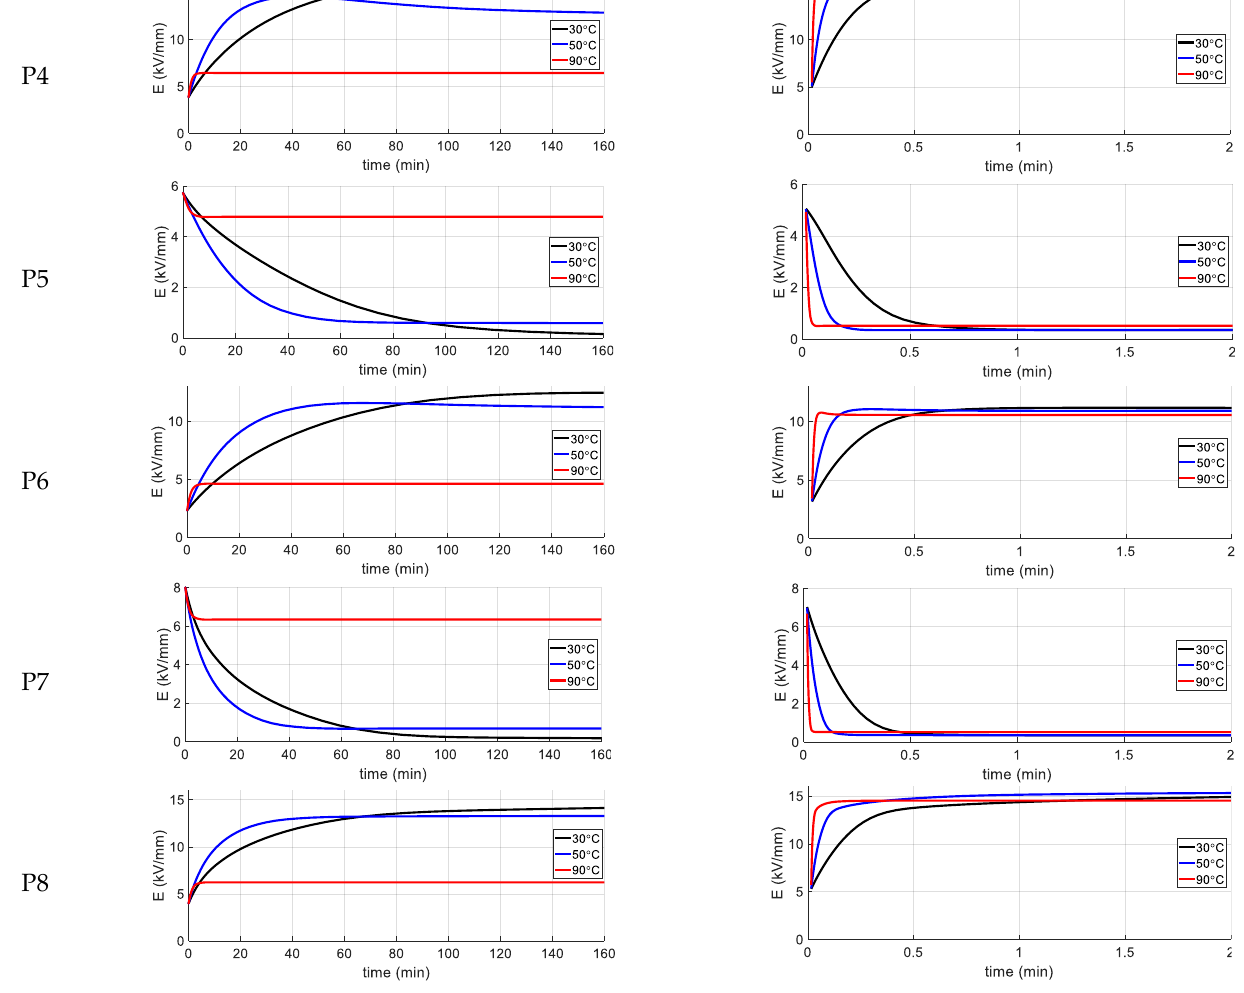
Figure 10. The time variation of stress curves of P1 to P8 using: ( left ) mineral oil; ( right ) ester oil.